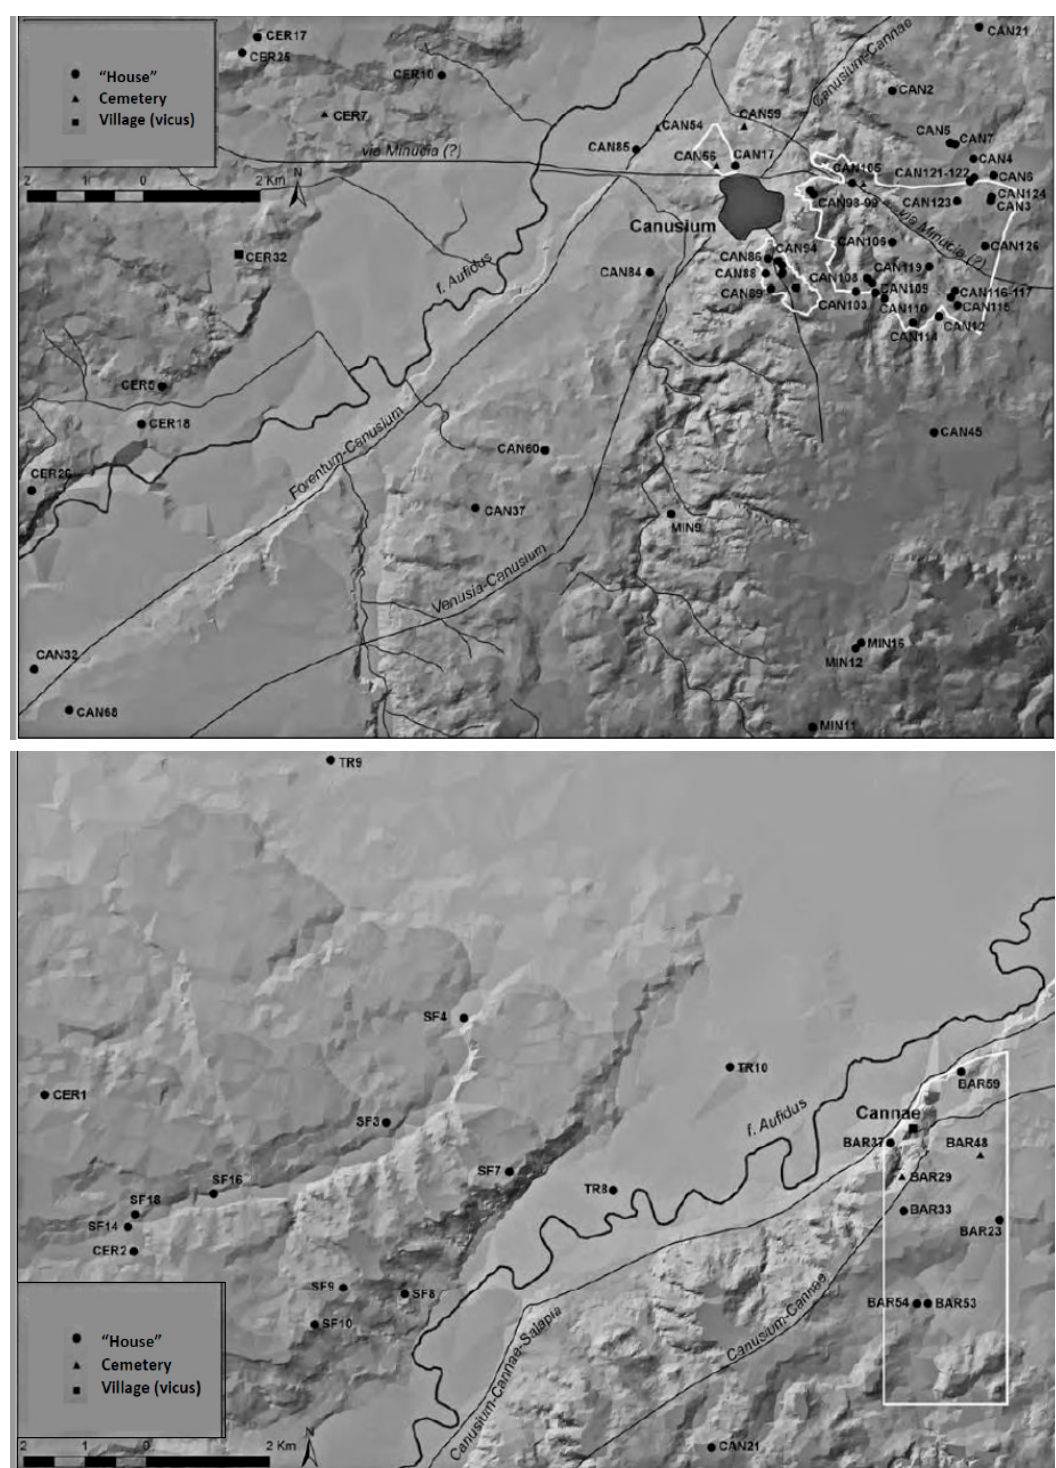
Figure 4. Sites around Canusium ( top ) and Cannae ( bottom ) identified in the Ofanto survey, second-first centuries BCE (adapted from Goffredo 2010 with permission).